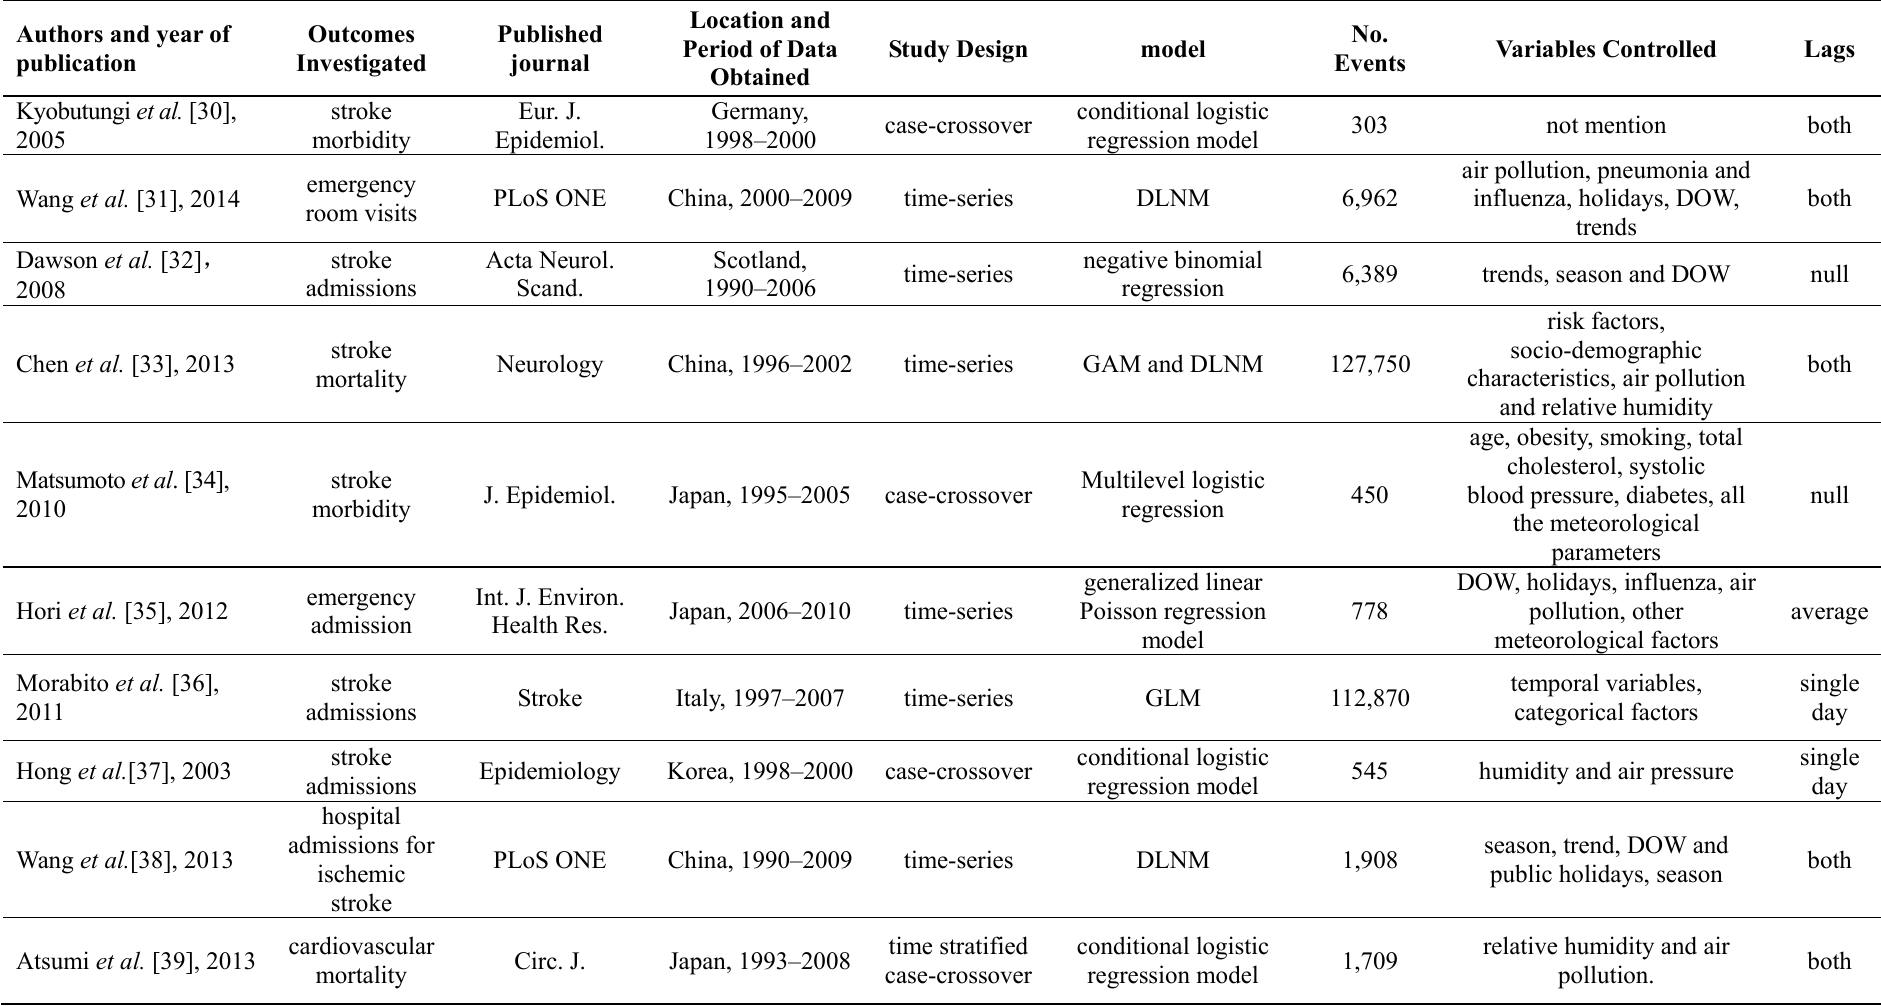
Table 1. Characteristics of the included